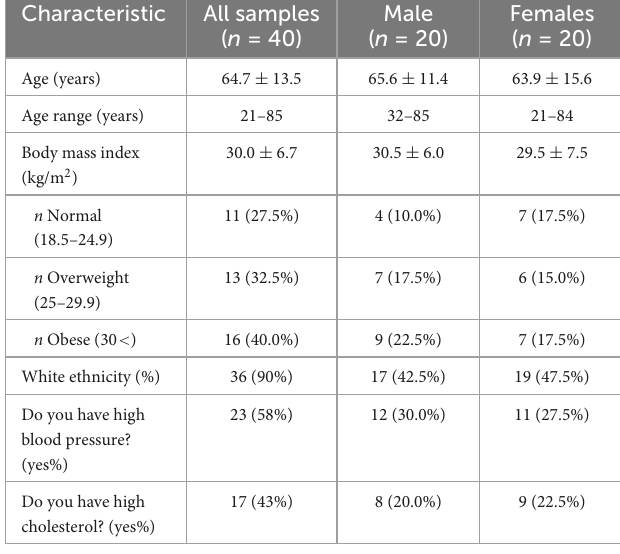
TABLE 1 Demographic characteristics of all participants in initial protocol online questionnaire ( n = 40).